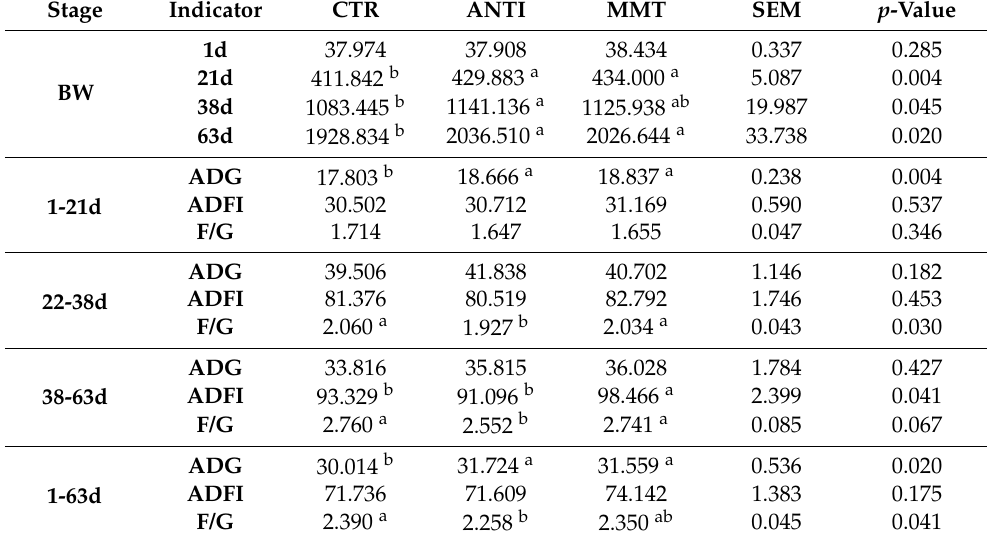
Table 3. Effect of MMT on the growth performance of yellow-feathered